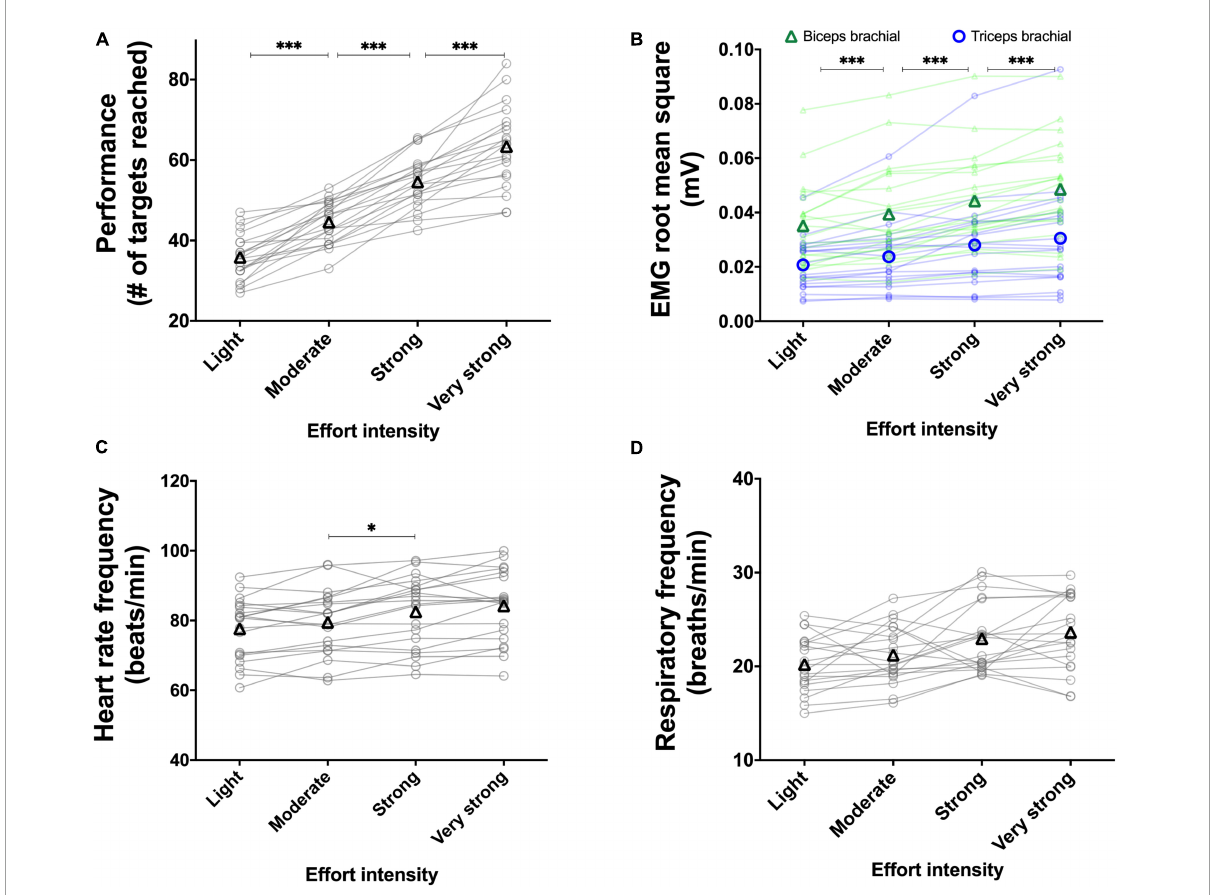
FIGURE4 Experiment 1A: Using the perception of effort to prescribe the exercise during the pointing task. Effect of increasing the prescribed effort intensity on performance ( A , n = 20), EMG root mean square of the biceps (green line) and triceps (blue line) brachial muscles ( B , n = 20), heart rate frequency ( C , n = 20), and respiratory frequency ( D , n = 20) during the pointing task. The exercise was prescribed at four intensities of perceived effort via the CR100 scale: light (13/100), moderate (23/100), strong (50/100), and very strong (70/100). Data are presented as the main effect of effort intensity (A, C, D) and effort intensity × muscle interaction (B) . Individual data are presented in light markers and means in dark markers. *Main effect of intensity, the difference between two effort intensities. * p < 0.05, *** p <